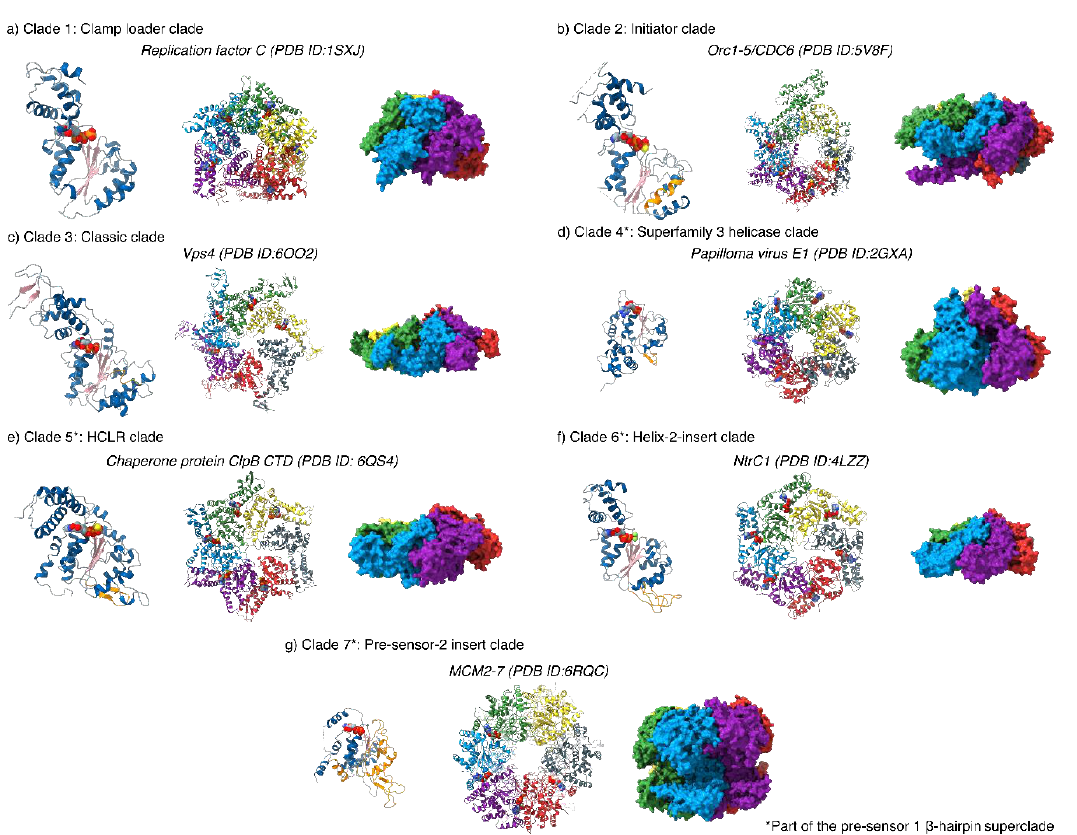
Figure 2. An overview of the di ff erent AAA + protein clades. All AAA + proteins form higher order homo- or hetero-oligomers that form asymmetric ring structures with heterogeneous nucleotide occupancies (28–33). All monomers contain a nucleotide binding site for ATP, and additional insertions (highlighted in orange on the monomer structures) that aid their unique functions. For monomeric structures: α -helices are coloured in blue; β -sheets, pink; insertions, orange and nucleotide and nucleotide analogues coloured by